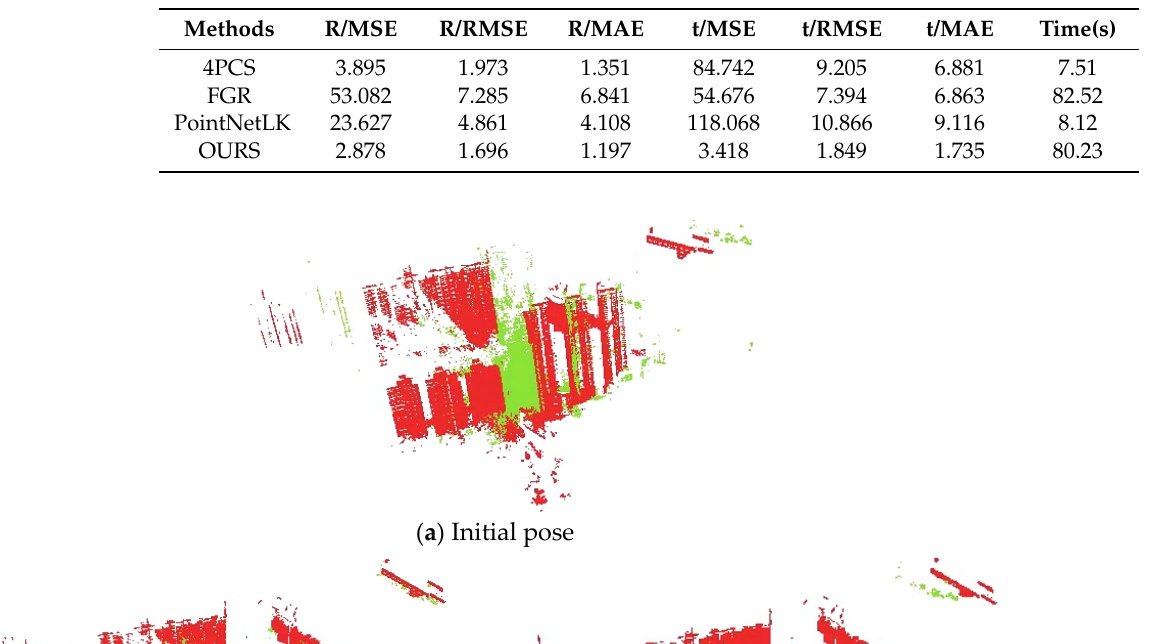
Table 7. Registration error and time of different methods for residence scenes.